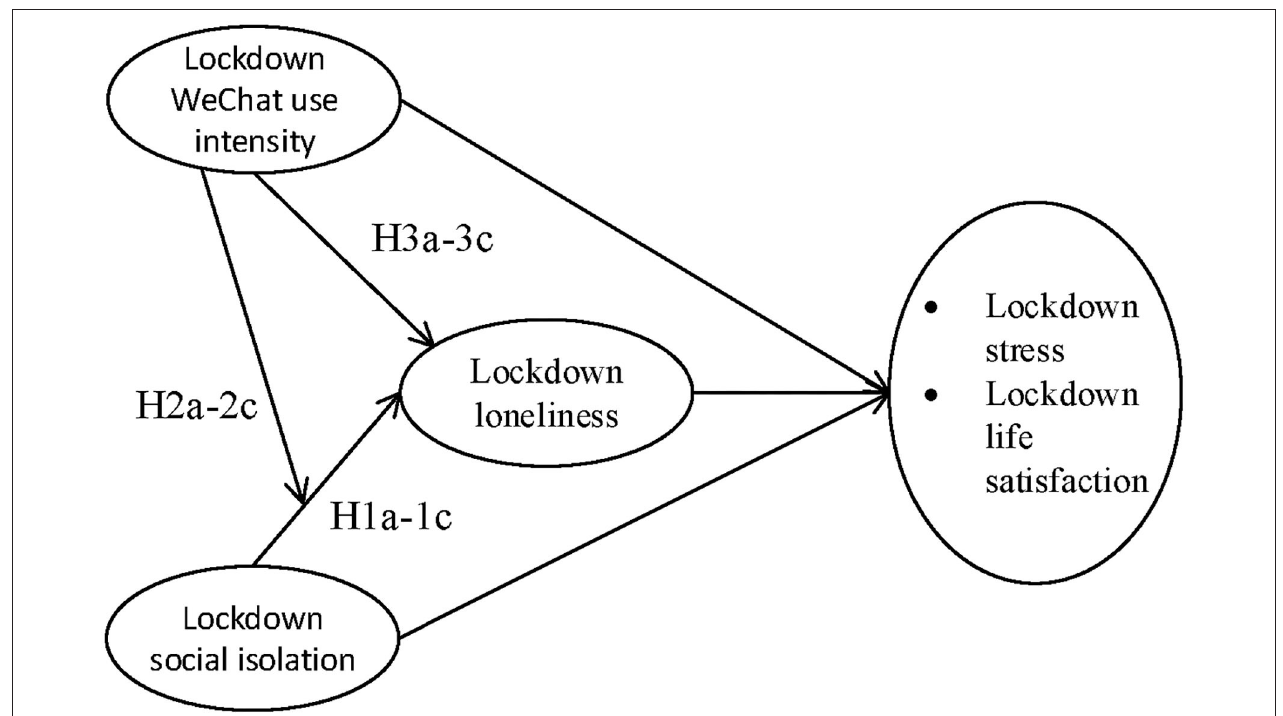
FIGURE 1 | Conceptual